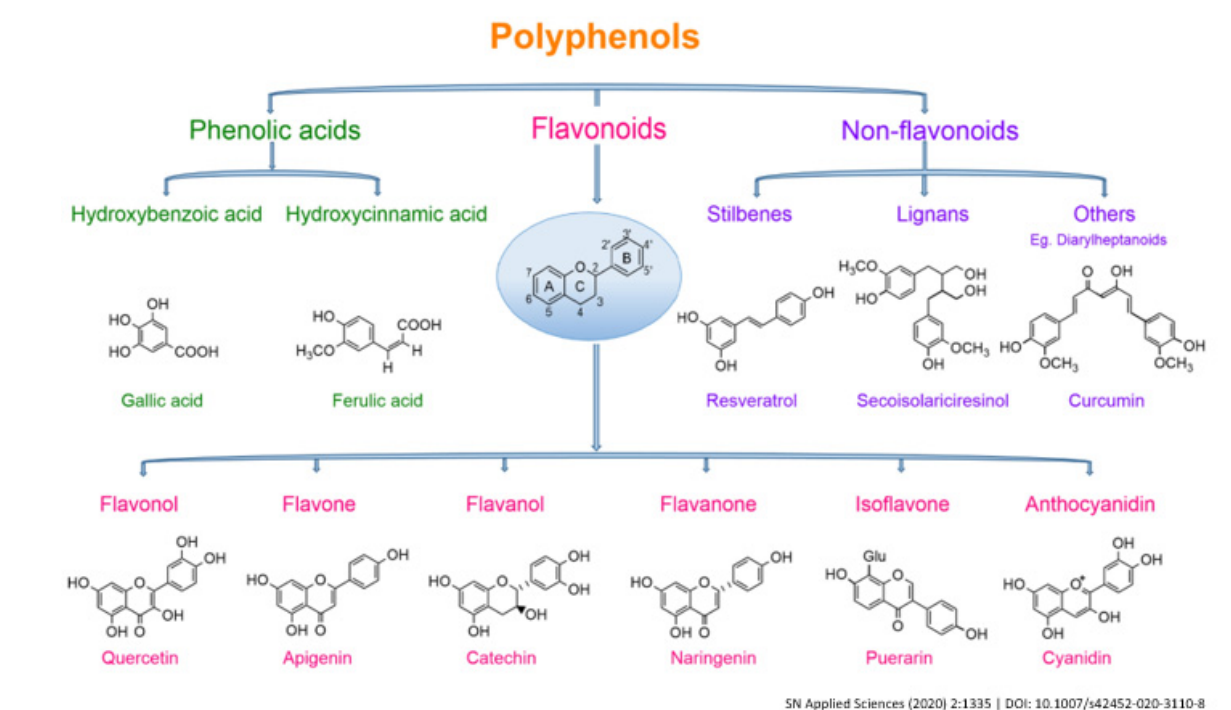
Figure 1. Classification of polyphenols [7].